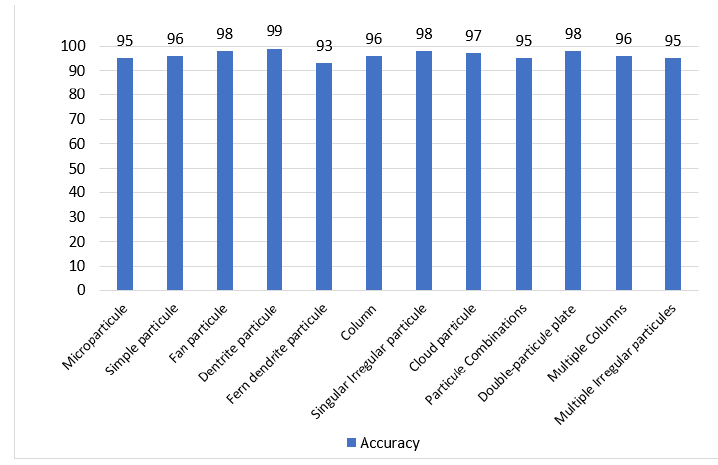
Figure 5. Classification accuracy percentage for the specific output classes.